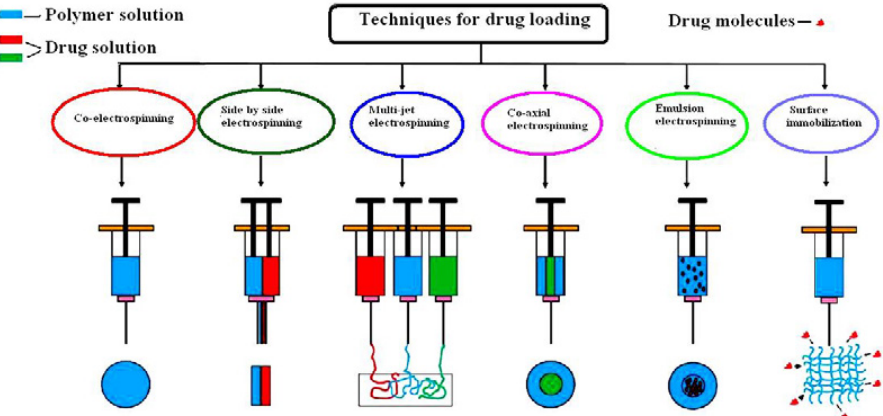
Fig. 1 . Scheme of a standard horizontal electro-spinning setup including at least one syringe pump, a polymer- with or without drug, a high voltage supply, a source electrode, and a collector electrode.